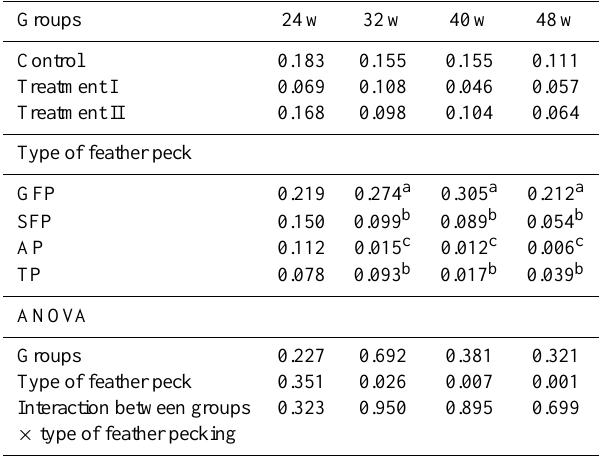
Table 4. The mean rate of pecking behaviour in the groups and mean proportion of different pecking behaviour